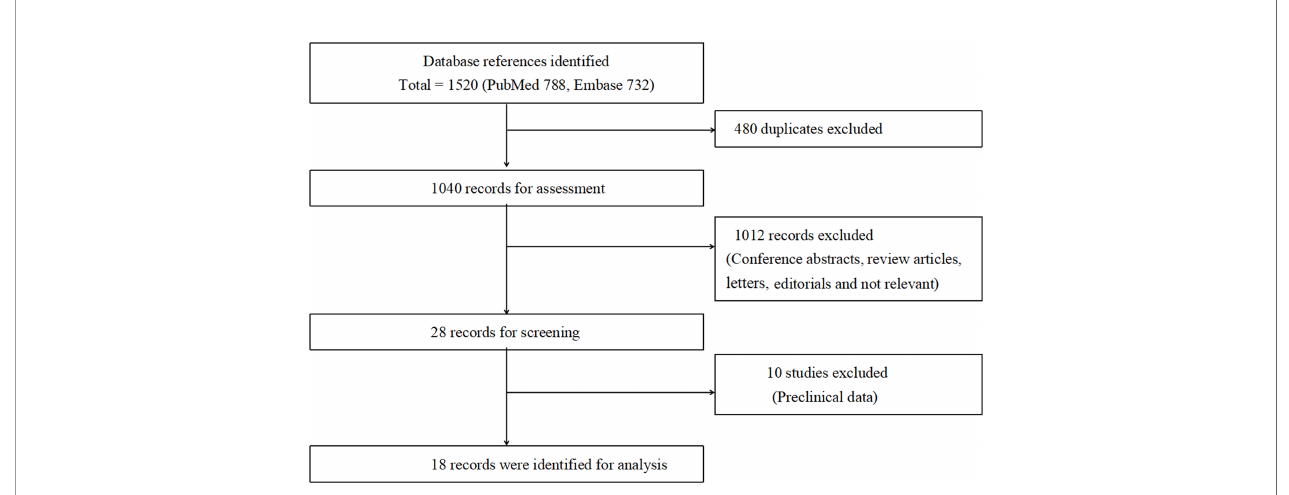
FIGURE 1 | Flow diagram of the